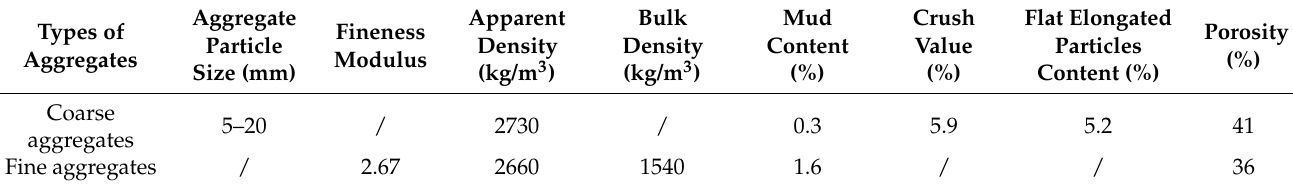
Table 2. Performance indicators of aggregates.